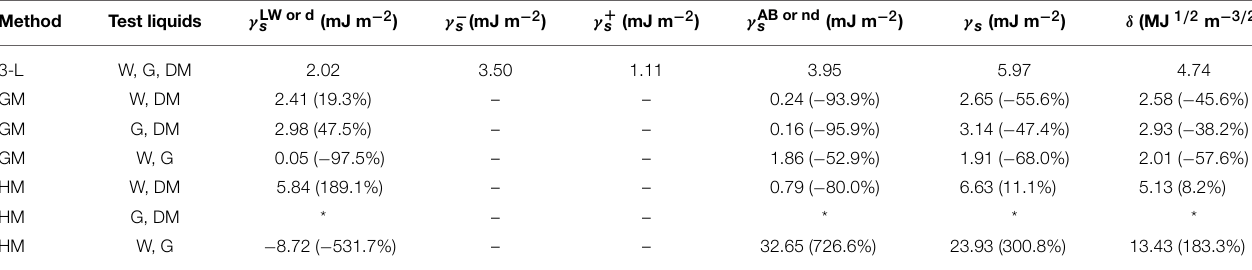
TABLE 5 | Surface free energy ( γ s ) and its components ( γ LW or d s